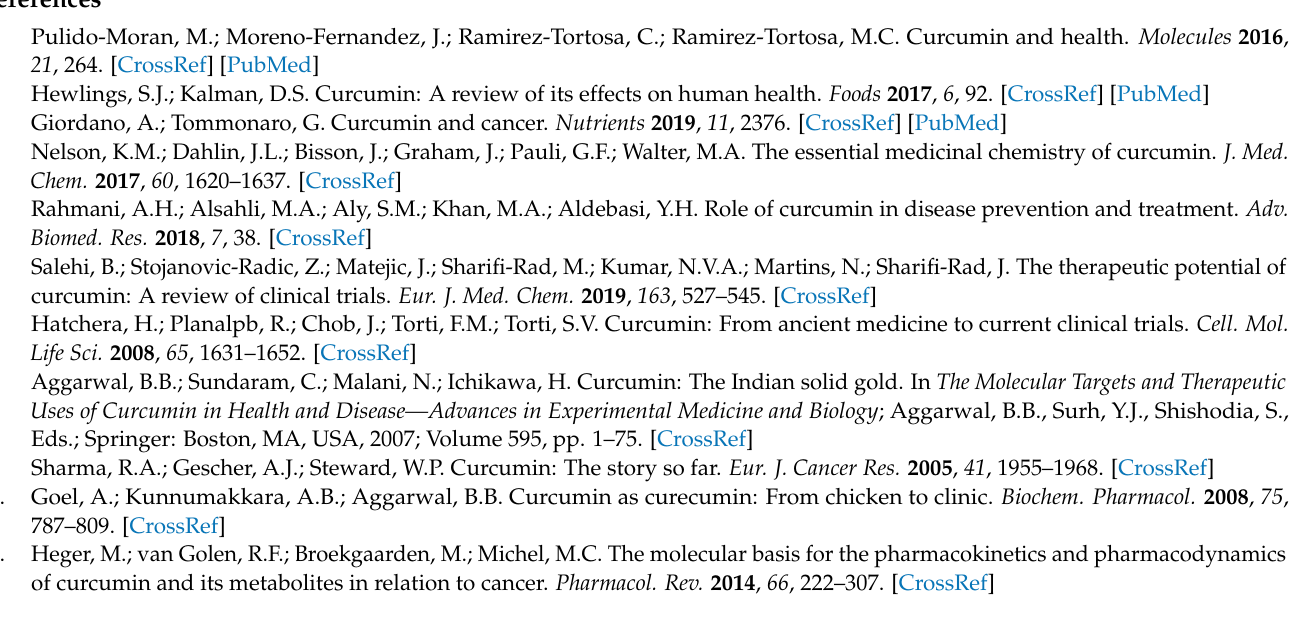
Figure S2. 1 H-NMR spectra of 3 in selected solvents. From top to bottom: Toluene- d 8 ; Chloroform- d , Dichloromethane- d 2 , and Acetonitrile- d 3 ; Figure S3. 1 H-NMR spectra of 2 in Toluene- d 8 at selected temperatures from room temperature to 188 K; Figure S4. 1 H-NMR spectra of 3 in Toluene- d 8 at selected temperatures from room temperature to 188 K; Figure S5. Zoom on the enolic proton region of the 1 H-NMR spectra of 2 in Toluene- d 8 at selected temperature ranging from room temperature to 188 K; Figure S6. Zoom on the enolic proton region of the 1 H-NMR spectra of 3 in Toluene- d 8 at selected temperature ranging from room temperature to 188